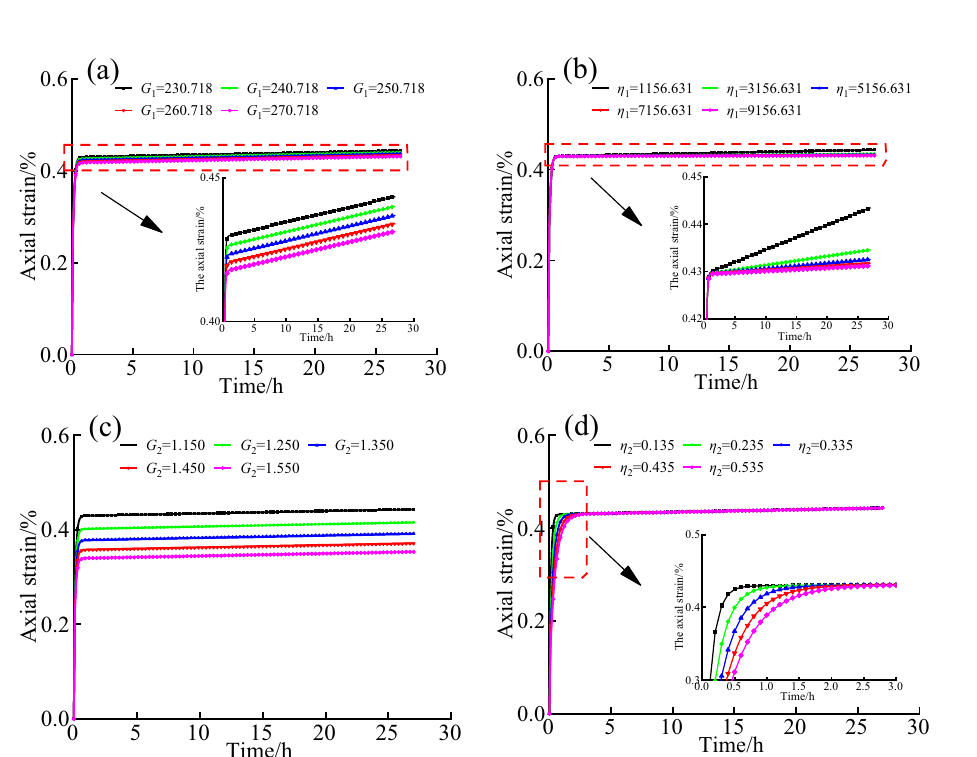
Figure 6. Creep curves of rock with different G 1 , η 1 , G 2 and η 2 ( a ) G 1 , ( b ) η 1 , ( c ) G 2 , ( d ) η 2